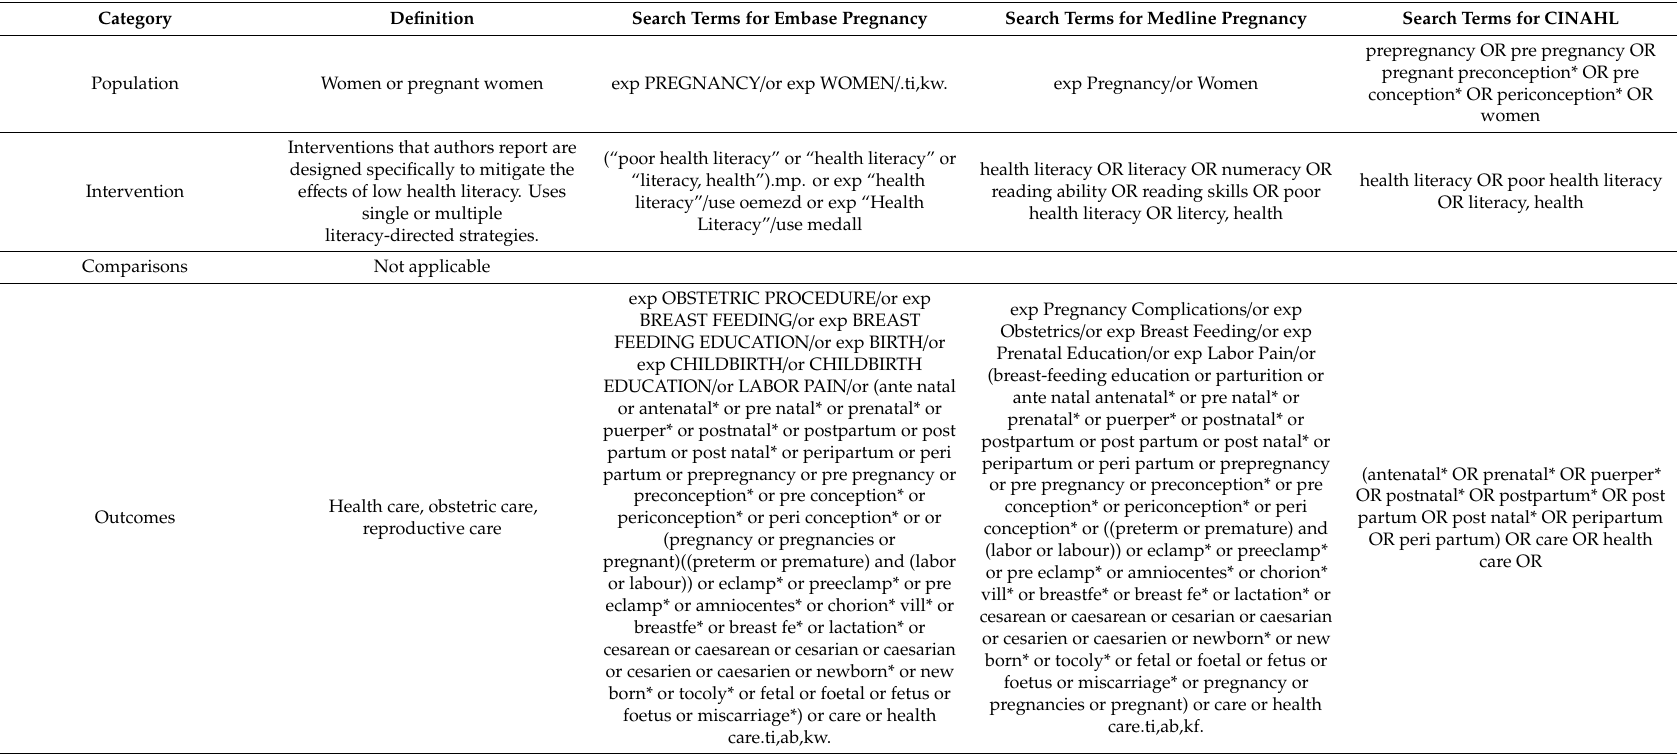
Table 1. PICO strategy: category, definition, and search terms in